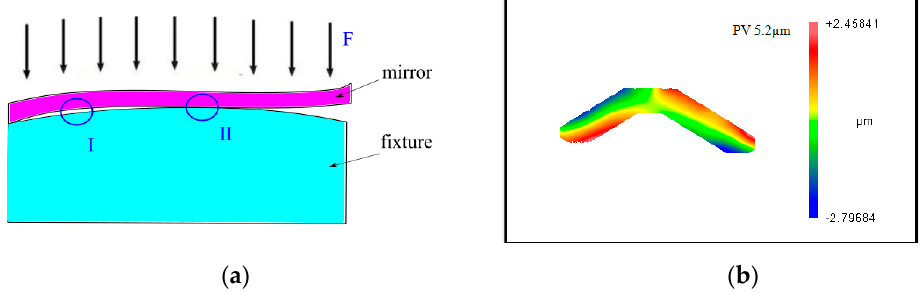
Figure 2. ( a ) Contact surface of the mirror and the fixture (I is the non ‐ contact area, II is the contact area) and ( b ) the clamping deformation of a weak ‐ stiffness mirror.